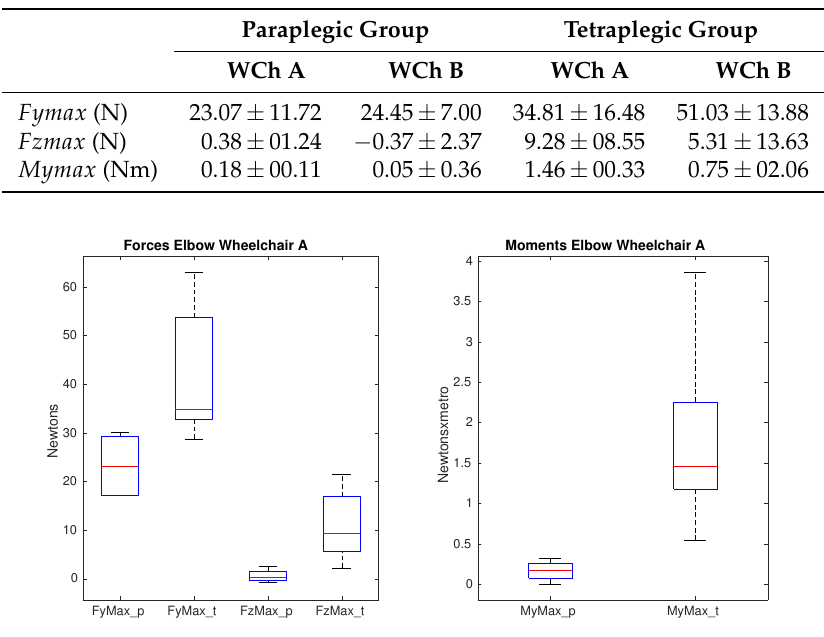
Figure 7. Forces and moments that show significance on the elbow between paraplegics and tetraplegics when propelling wheelchair A. FyMax represents the maximum value of lateral force on the elbow, FzMax shows the maximum superior force on the elbow. MyMax shows the maximum value of the flexion moment. In all cases, the values for paraplegics (_p) and tetraplegics (_t) are shown. Nevertheless, on this joint there is no difference impacted by the use of a different